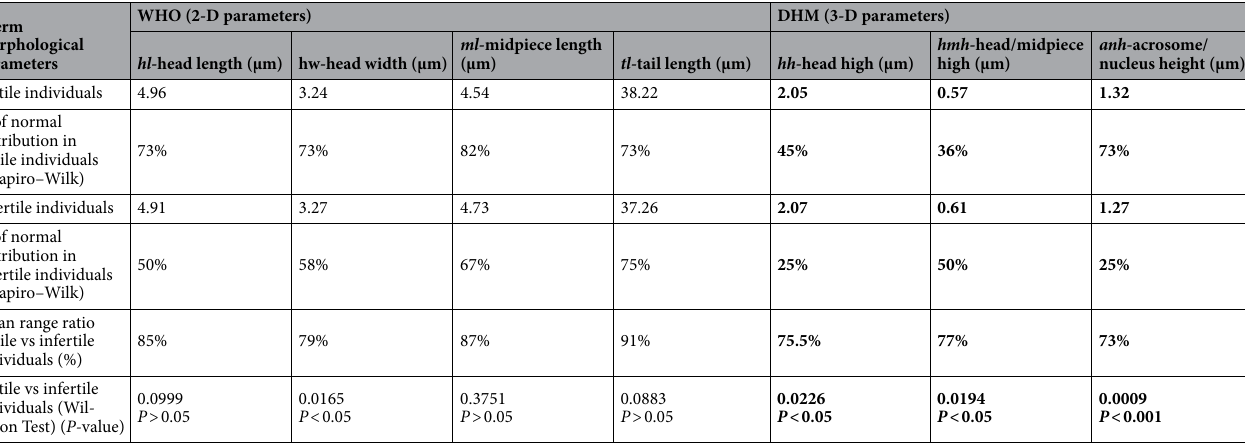
Table 2. Mean values of sperm parameters measured by DHM for fertile and infertile men. Significance values are in